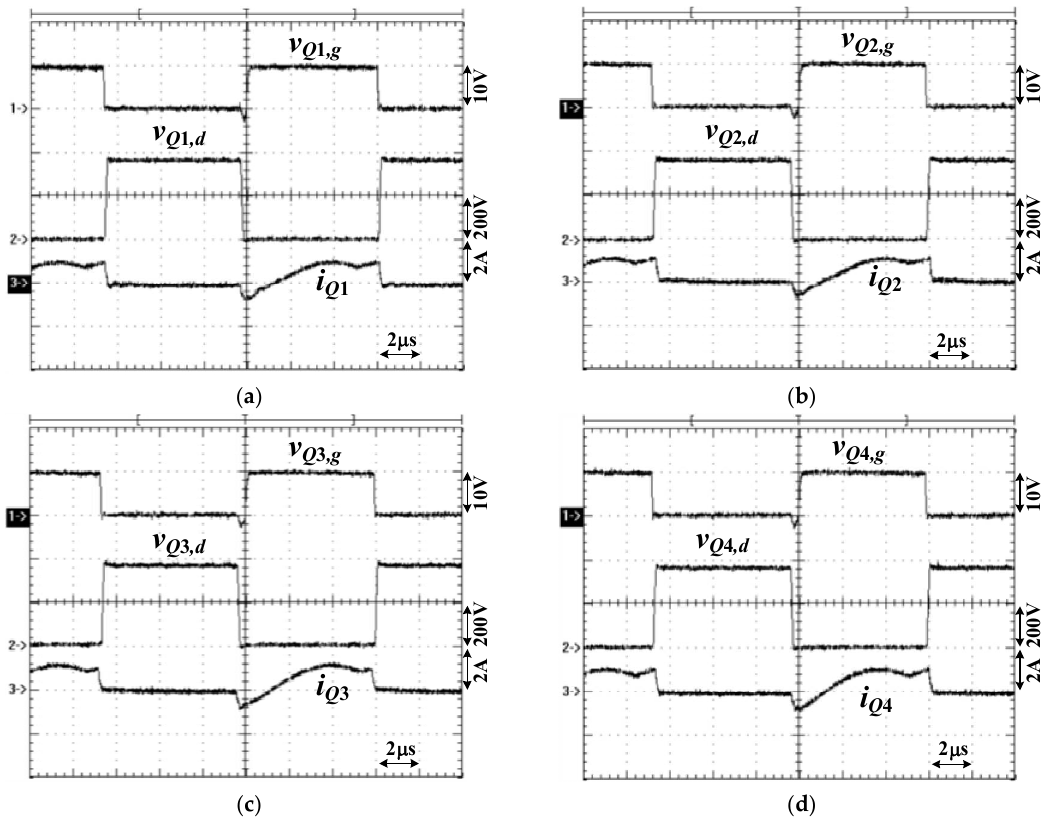
Figure 12. Commutation of switches Q 1 ~ Q 4 under 20% load ( a ) Q 1 ; ( b ) Q 2 ; ( c ) Q 3 ; ( d ) Q 4 .